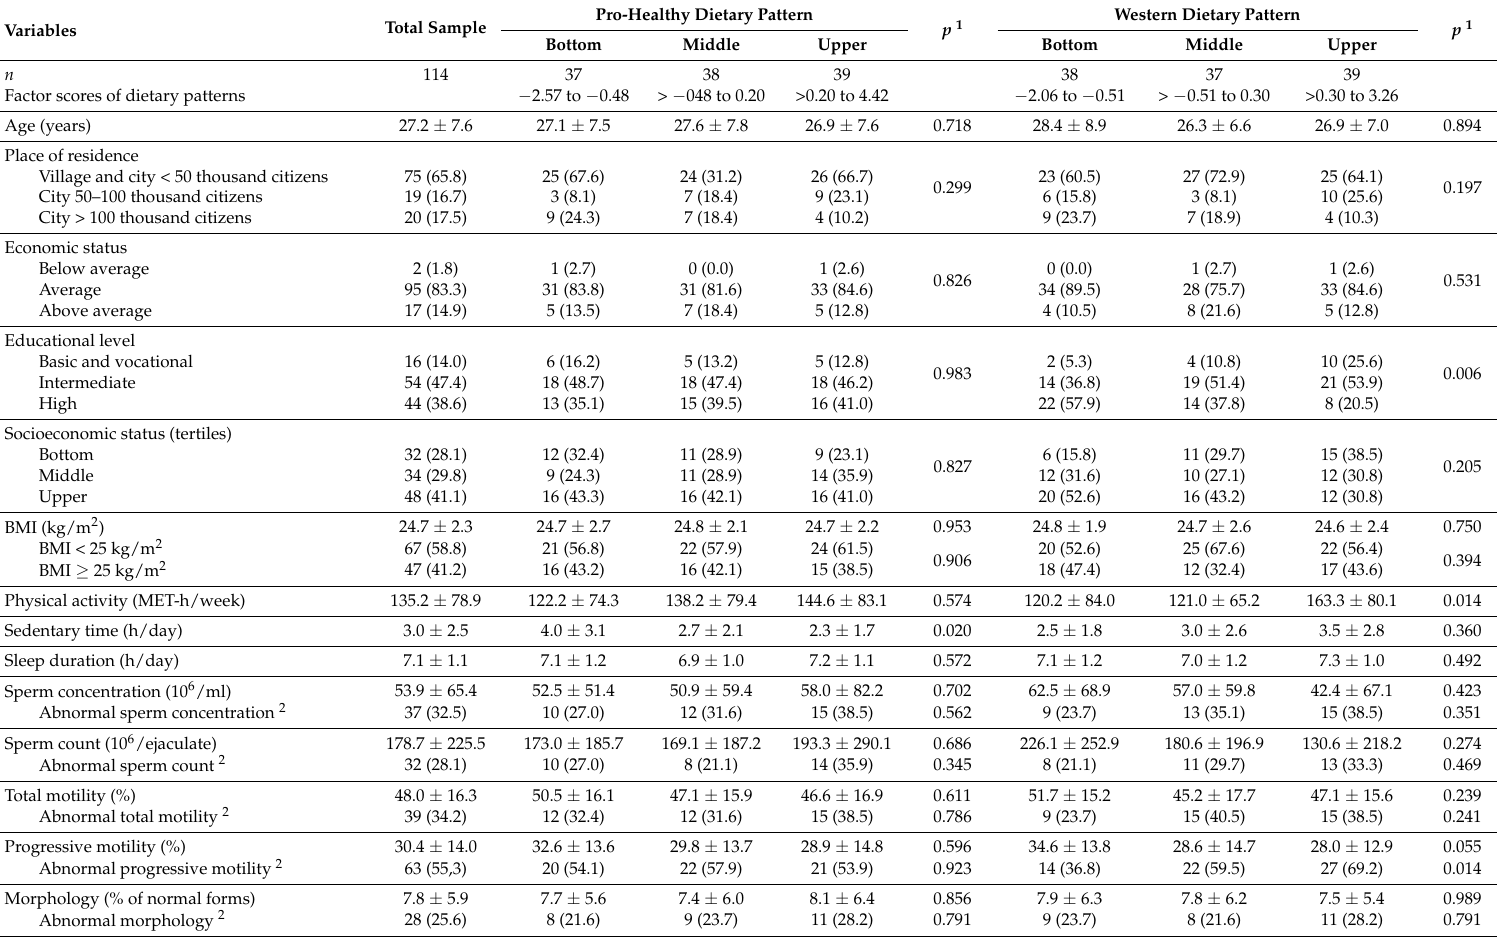
Table 3. Characteristics of the participants across tertiles of dietary